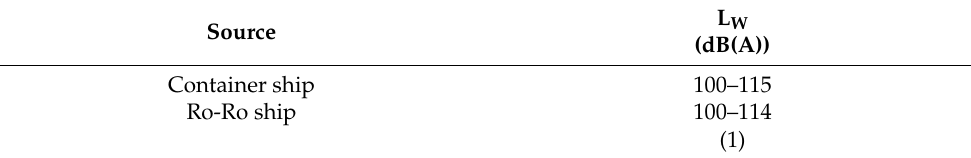
Table 3. Approximate sound power level of some port noise sources given by